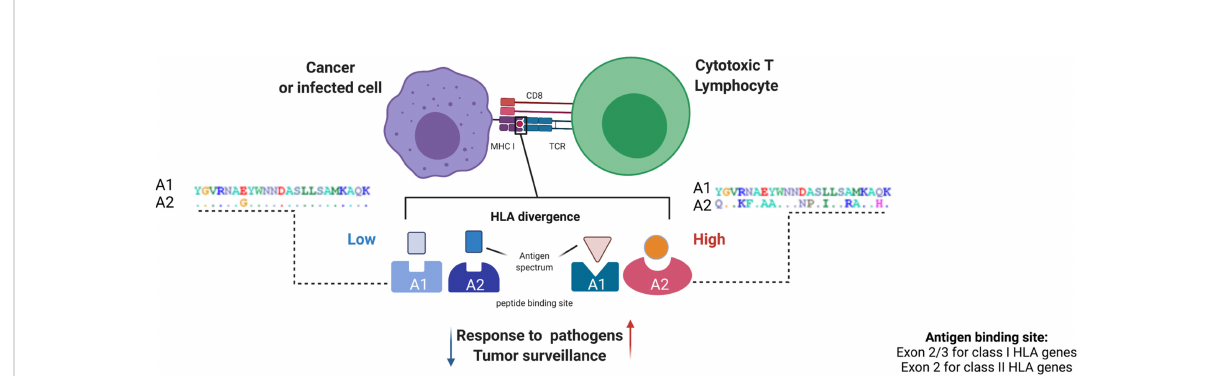
FIGURE 3 HLA evolutionary divergence calculation and pathophysiological implications. The HED score between two HLA alleles approximates the functional dissimilarity between the encoded molecule variants based on the Grantham distance between the amino acid sequences of their peptide binding domains. This computation is made using a dictionary including all the protein sequences of exons 2 and 3 for class I alleles and exon 2 for class II alleles, assembled from the IPD-IMGT/HLA database. (39) From a pathophysiological point of view, the divergence of HLA binding sites can in fl uence patterns of antigen presentation in different processes, from response to infections to tumor surveillance, with a higher HLA divergence being associated with stronger immunocompetence and vice versa. At the right and the left as an example, A1 and A2 represent two alleles of the same locus. Each letter of A1 indicates an amino acid in the peptide binding site. In A2 letters designate variable amino acids (polymorphisms) and dots denote constant residuals. A1 and A2 on the left harbor a lower variability (low number of polymorphic residues) as compared to A1 and A2 on the right (higher number of polymorphic amino acids). Figure created with